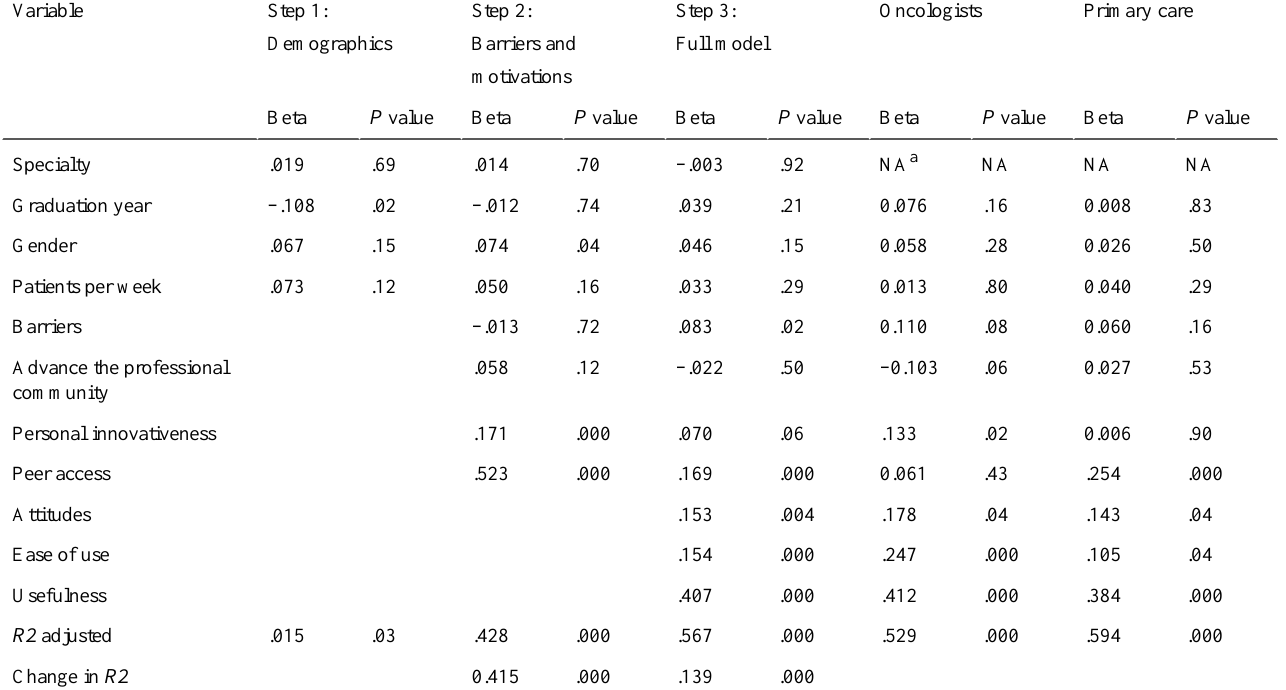
Table 3. Hierarchical regression results (standardized beta).